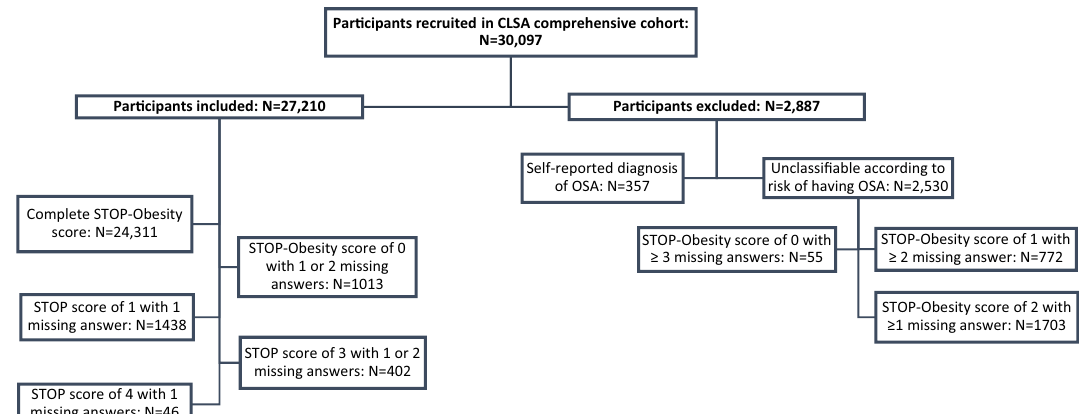
Figure 1. Flowchart describing the inclusion and exclusion of participants for analyses based on the surrogate STOP